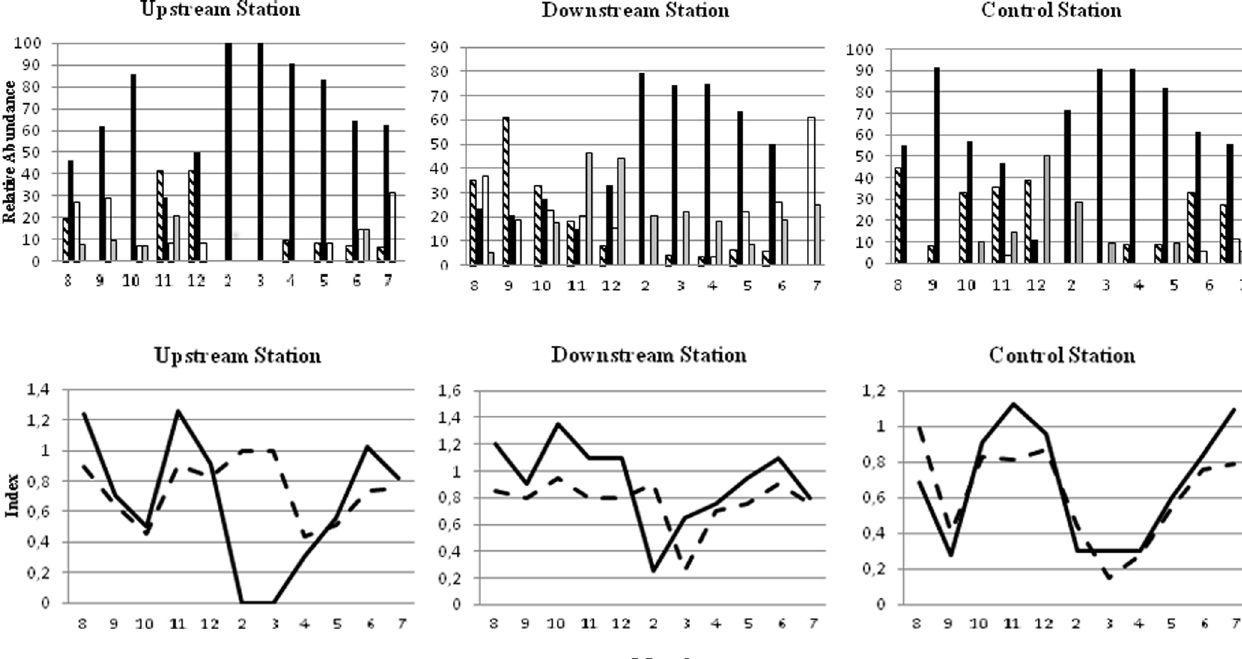
Fig. 3. Shannon-Wiener biodiversity Index (H') and Evenness (E) values for species collected monthly from upper, lower and control sites. Continuous line H'; dotted line: